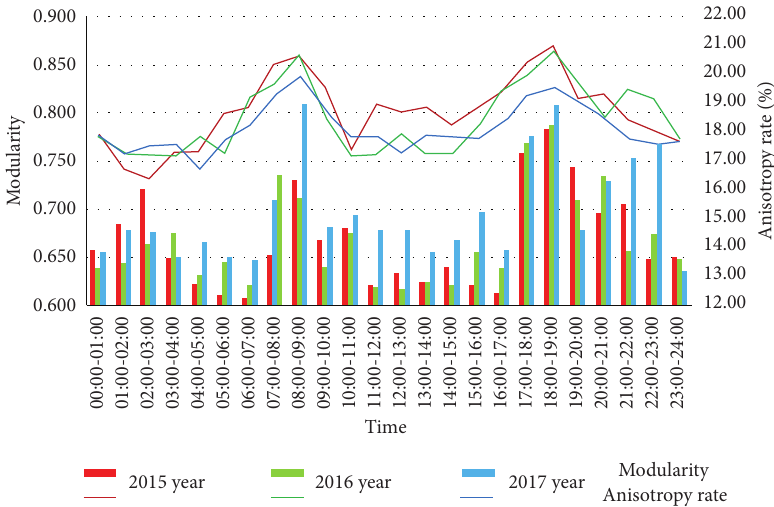
Figure 6: Graph of average community modularity and anisotropy